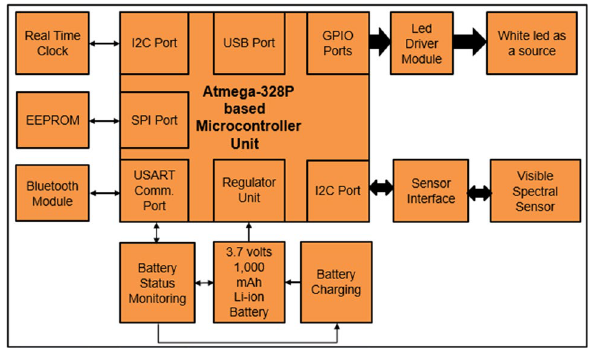
Fig. 5 Functional block diagram of developed handheld